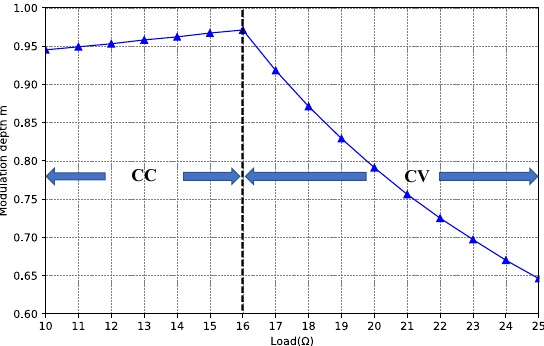
Figure 12. Adjustment process of modulation depth m with R L .